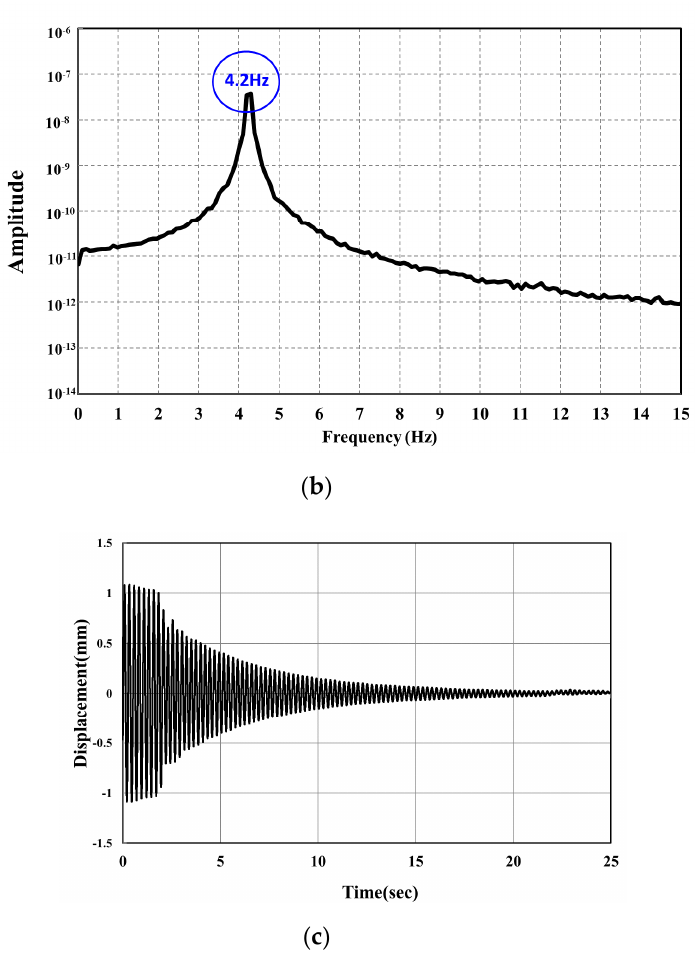
Figure 16. Dynamic characteristics of PSC I-girder specimen: ( a ) acceleration response under forced vibration by exciter; ( b ) FFT analysis; and ( c ) free vibration for analysis of damping ratio.